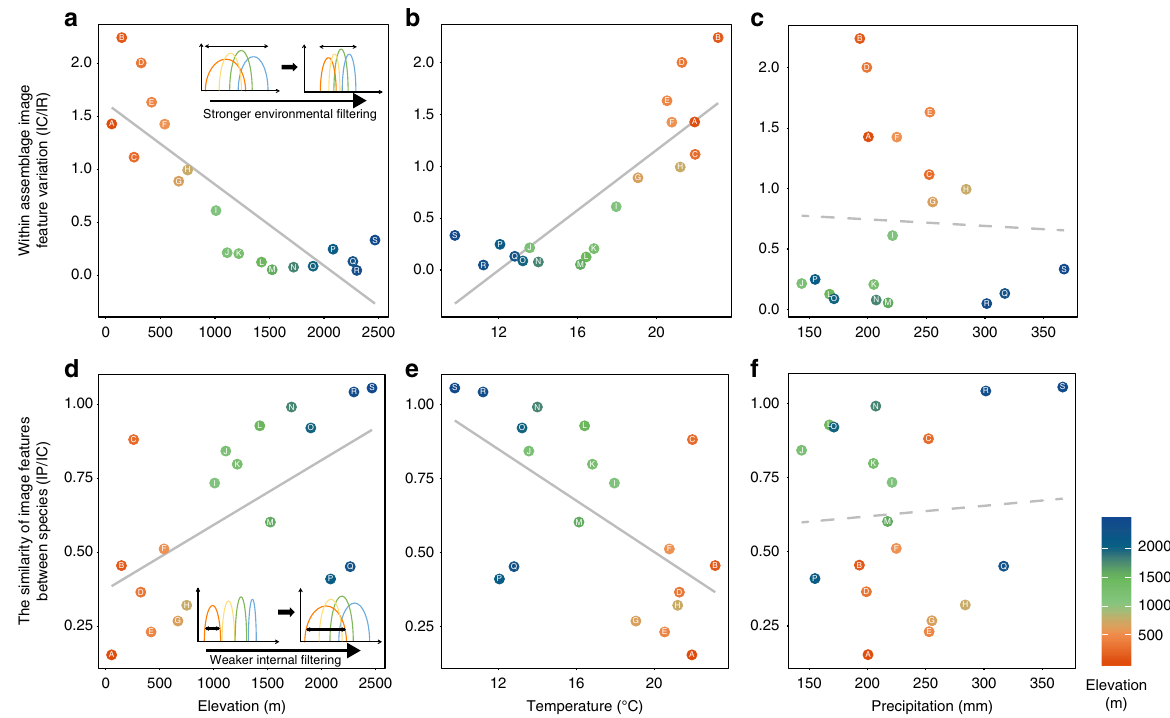
Fig. 4 Image feature variation at the assemblage and species levels along an elevational gradient. Within-assemblage-level image feature variation ( T IC/IR ) in relation to a elevation, b temperature and c precipitation. T IC/IR is the ratio of community/assemblage-wide variance (Individual within-community/ assemblage) to total variance in the regional pool (individual within-region), assessed at the individual level. Smaller within-assemblage-level variation suggests stronger environmental fi ltering effect on the trait 20,21 . The similarity of image features between species at each assemblage, T IP/IC , in relation to d elevation, e temperature and f precipitation. T IP/IC is the ratio of within-population variance (individual within-population) to total within-community/ assemblage variance (individual within-community/assemblage). A higher T IP/IC ratio suggests less competition among species of the same assemblage. The grey solid and dashed lines represent signi fi cant and non-signi fi cant relationships, respectively. Warmer colours correspond to lower elevations, and cooler colours to higher elevations. Source data are provided as a Source Data fi